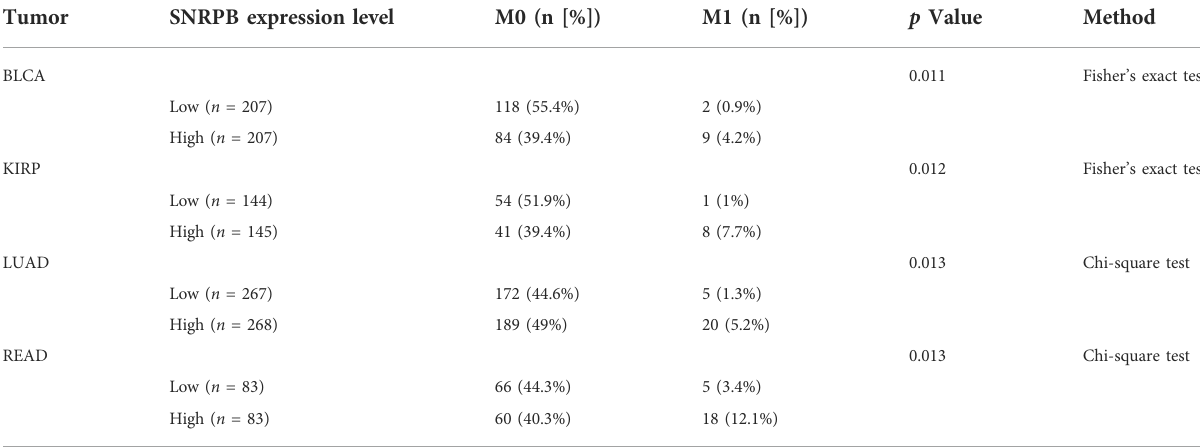
TABLE 3 The relationship between SNRPB expression and tumor M